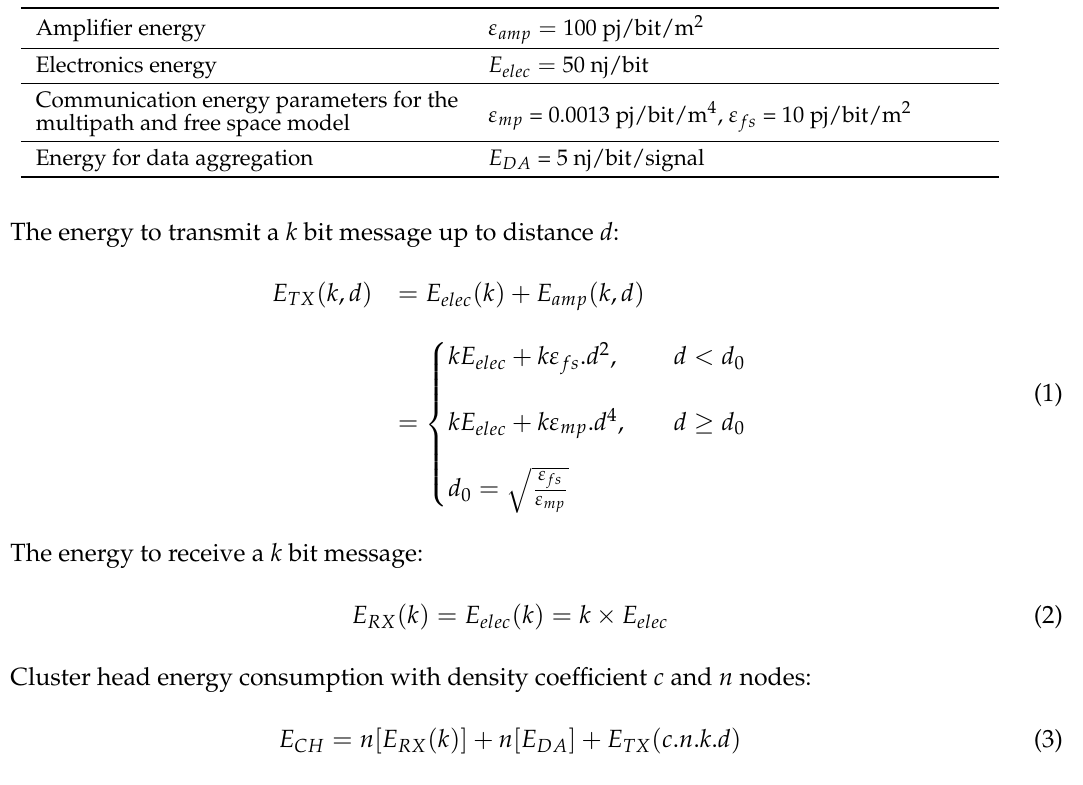
Table 1. Energy model used in the proposed